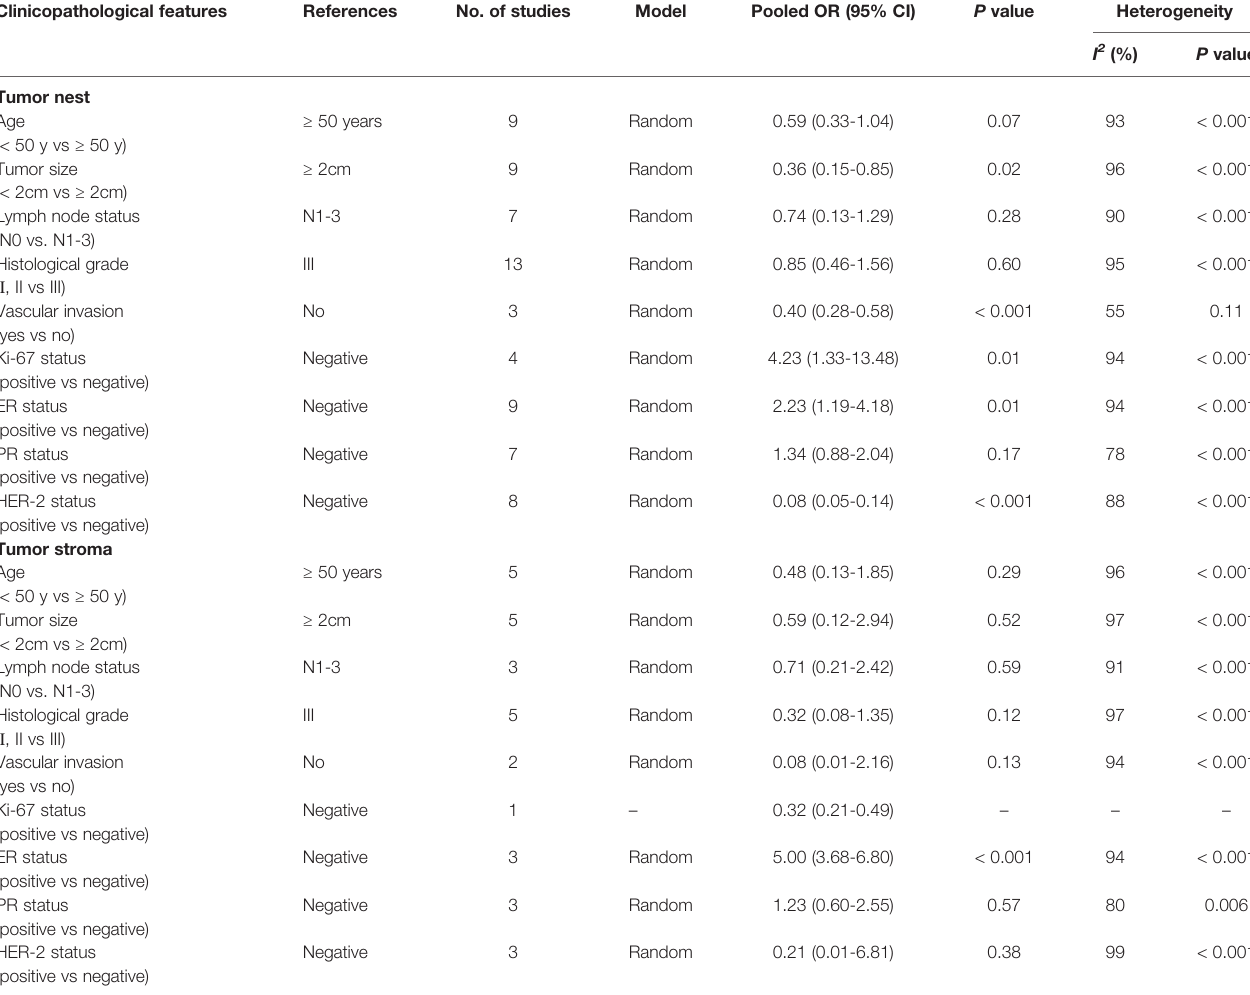
TABLE 2 | Meta-analysis of high CD68+ TAMs density and clinicopathological features of breast cancer patients. Clinicopathological